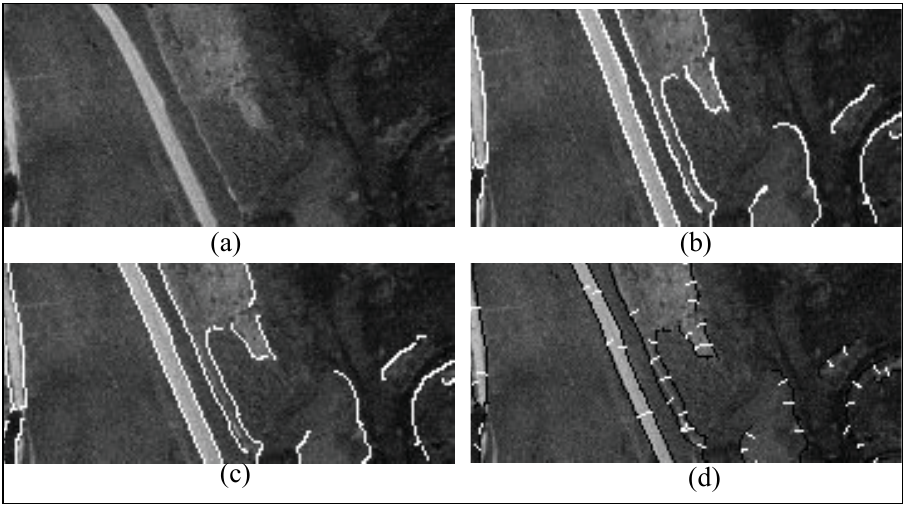
Fig. 3 – Construction of road objects. (a) original image; (b) Edge detected by Canny; (c) Edges vectorized; and (d) Edges polygonized and mean image gradient